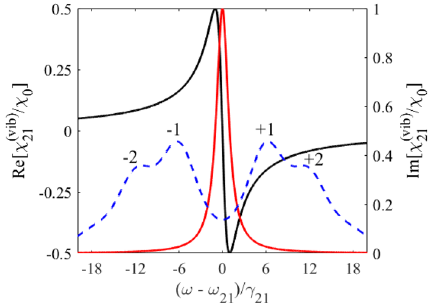
Figure 9. In the vibrating reference frame, real (black curve, left axis) and imaginary (red curve, right axis) parts of the resonant susceptibility Eq. (23) of the motionless absorber as well as the power spectral density of ω 21 , spectrally broadened, � LS the resonant, ω 0 = with Lorentz-squared spectral profile Eq. (47) (blue dashed line) under �